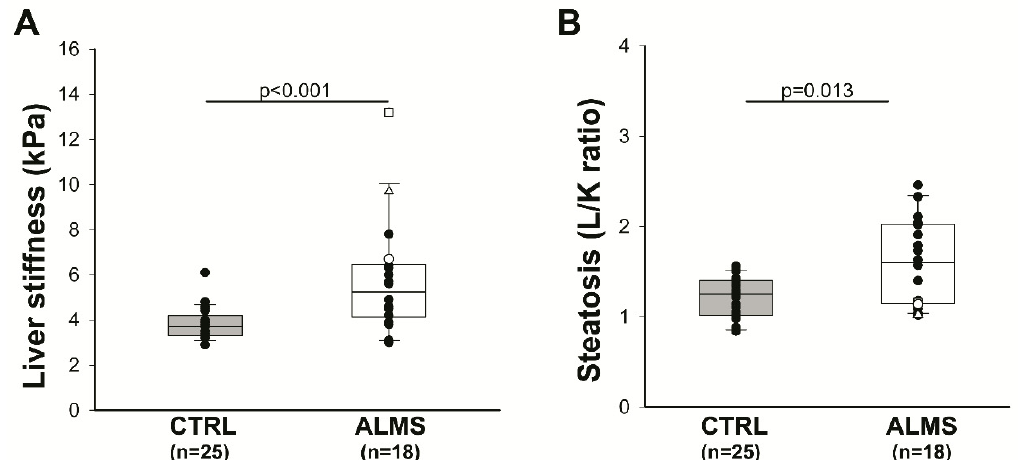
Figure 1. Liver fibrosis and steatosis in patients with ALMS: ( A ) liver stiffness evaluated by shear wave elastography in patients with ALMS and in controls (CTRLs); ( B ) liver steatosis quantified by the L/K in patients with ALMS and in CTRLs. Results are presented as a box plot, with 25th and 75th percentiles and median values. ID 1 (white triangle), ID 2 (white circle), and ID 5 (white square) patients had clinical signs of portal hypertension and are described in detail in Table 3. Statistical analysis was performed using the Mann–Whitney U-test.